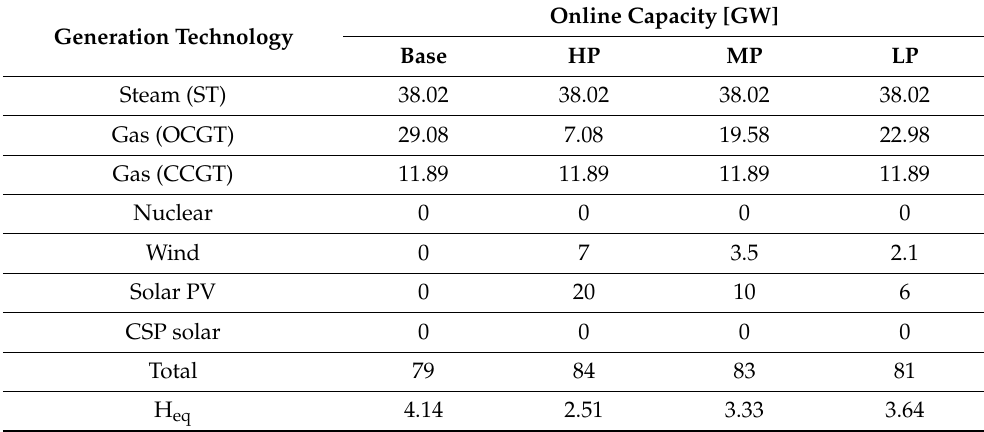
Table 5. Online generation under peak load conditions in